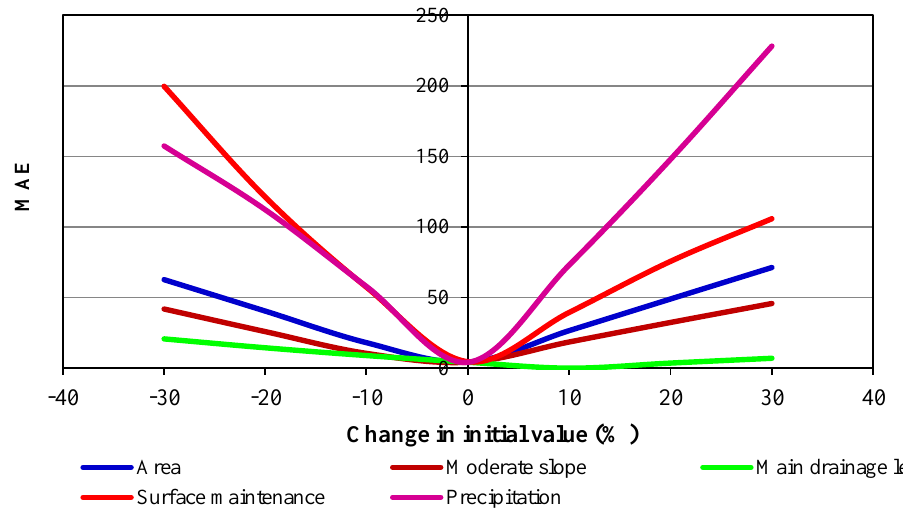
Figure 15. Results of sensitivity analysis performed on input parameters of El-Hames